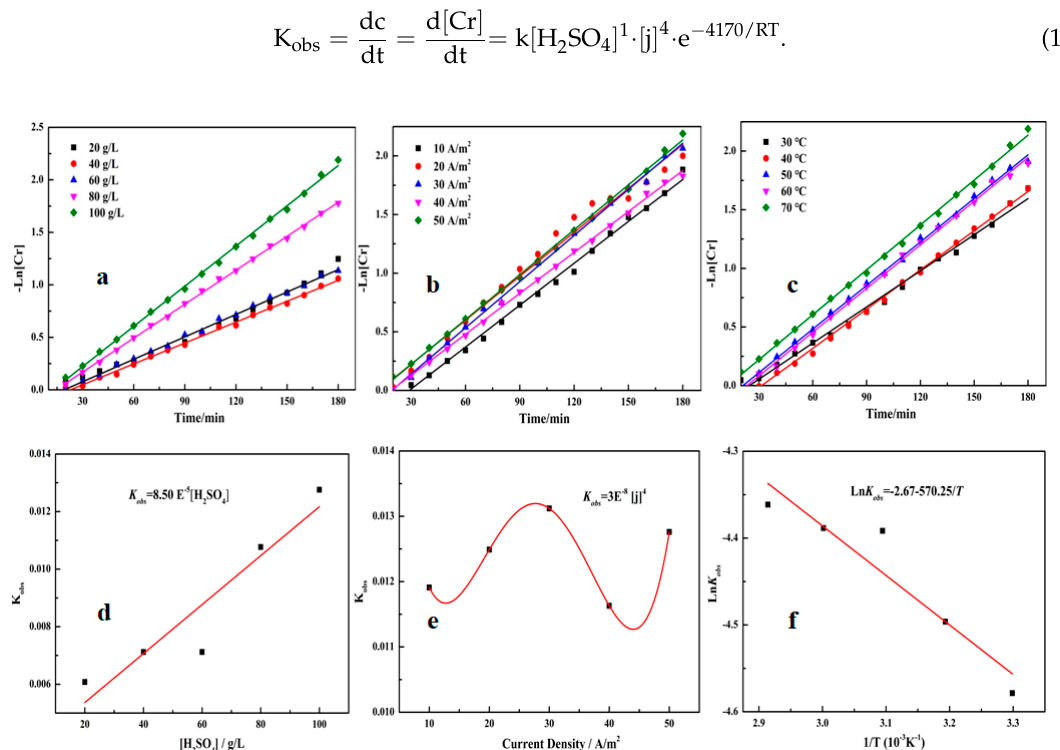
Figure 5. Pseudo-first-order models for the reduction of chromium (VI). ( a ): Effect of H concentration; ( b ): Effect of current density; ( c ): Effect of reaction temperature; ( d ): Plot of K obs as a function of H 2 SO 4 concentration; ( e ): Plot of K obs as a function of current density; ( f ): Plot of K obs as a function of reaction temperature